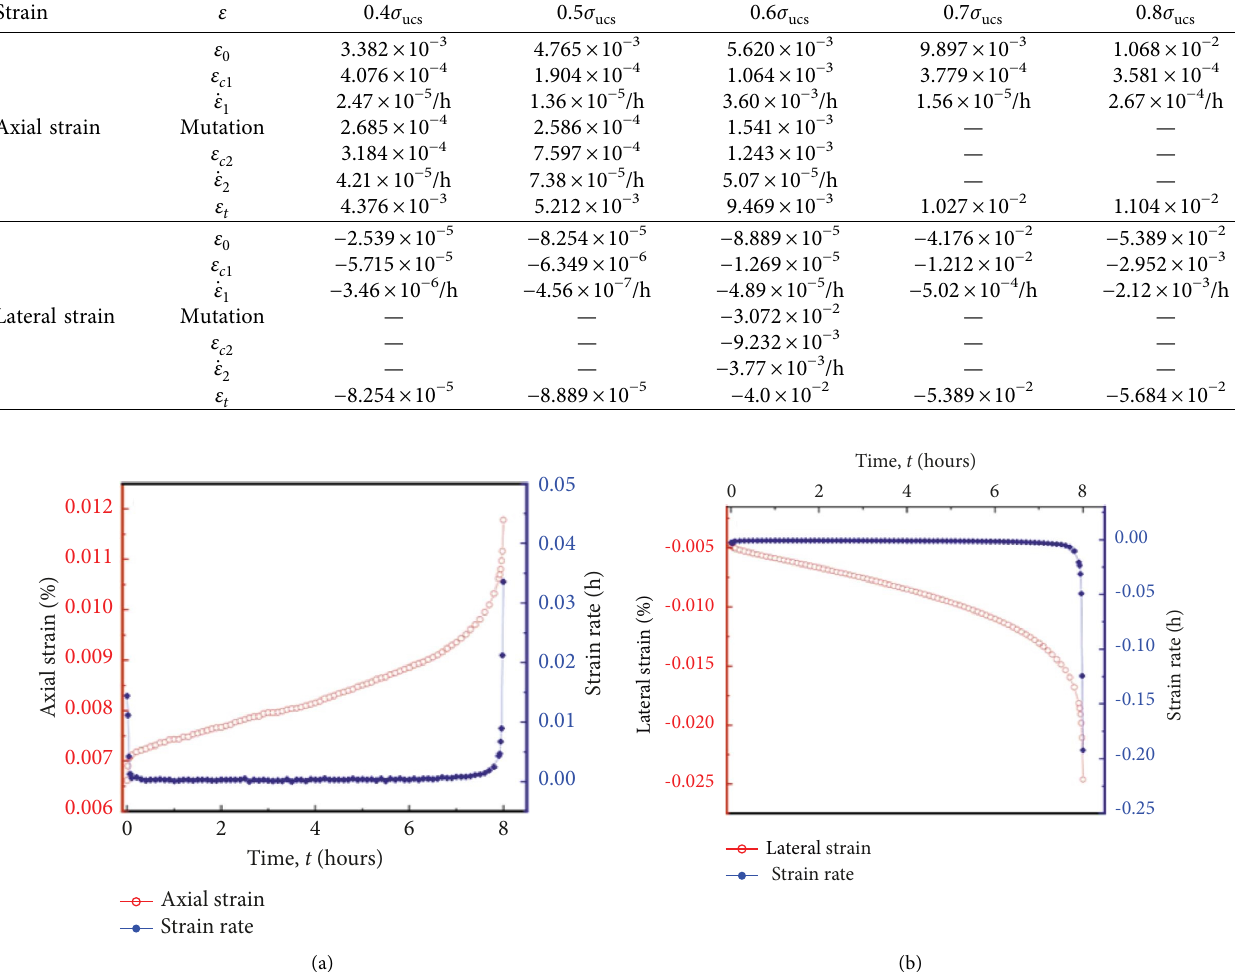
Figure 6: Creep strain and the associated creep strain rate of the natural sample at the fnal stress